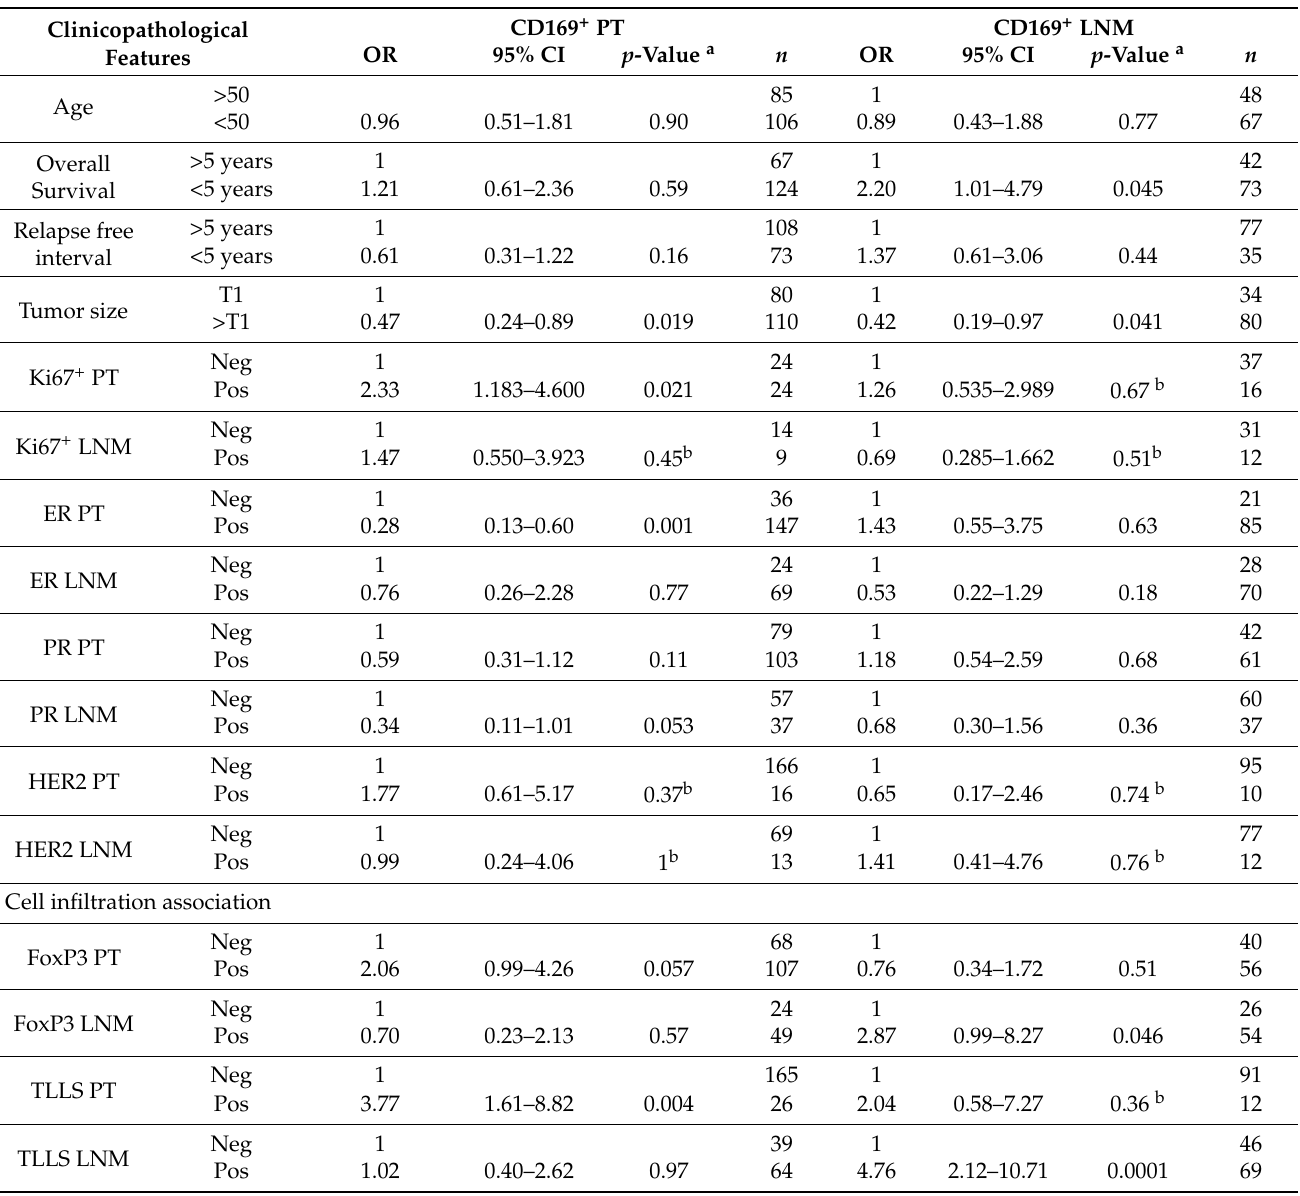
Table 2. Odds ratio table comparing CD169 + macrophage infiltration in PTs and LNMs with tumor and metastasis clinicopathological features as well as other immune cell